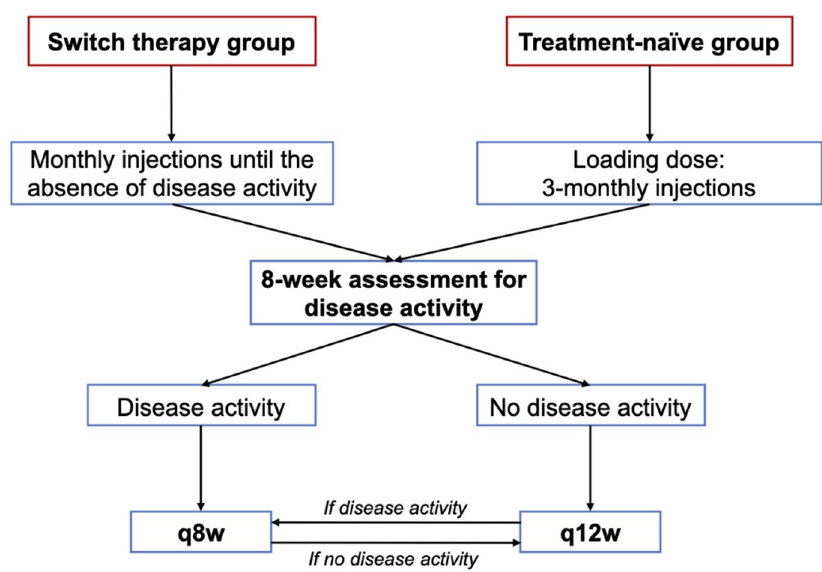
Figure 1. Our in-house protocol for the treatment of neovascular glaucoma with intravitreal injec- tions of brolucizumab.